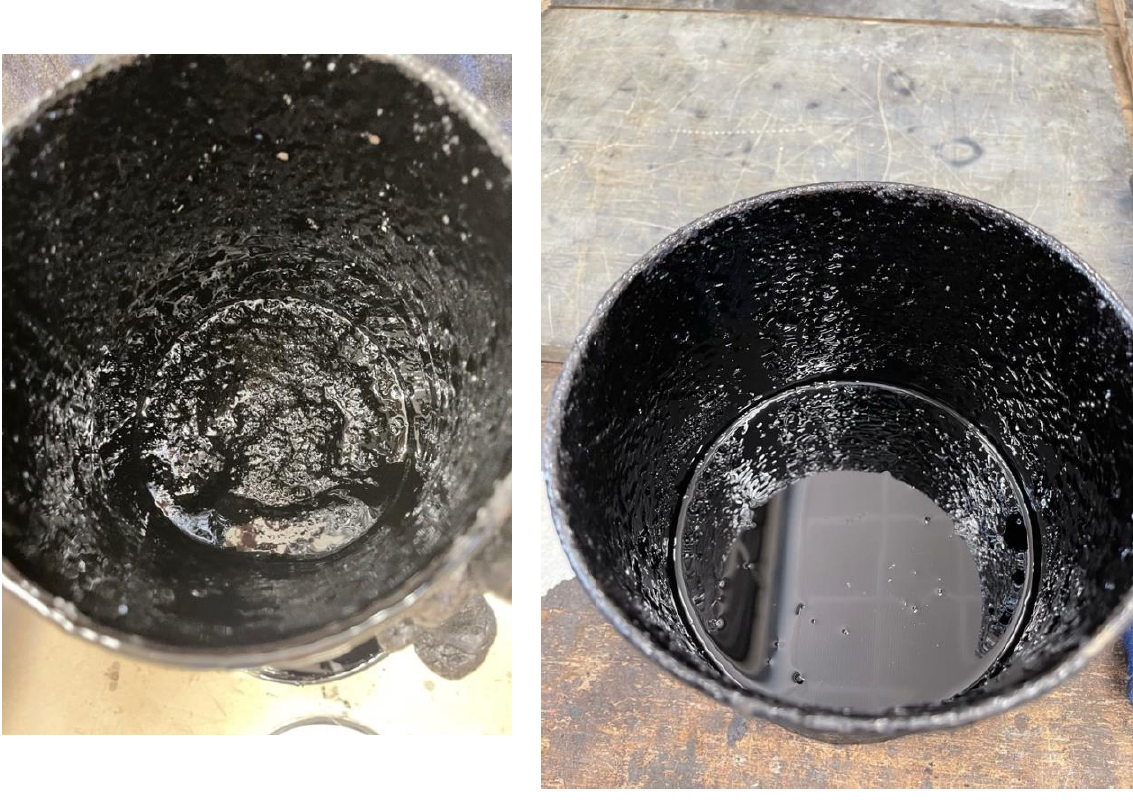
Figure 5. EPDM residue in bitumen.